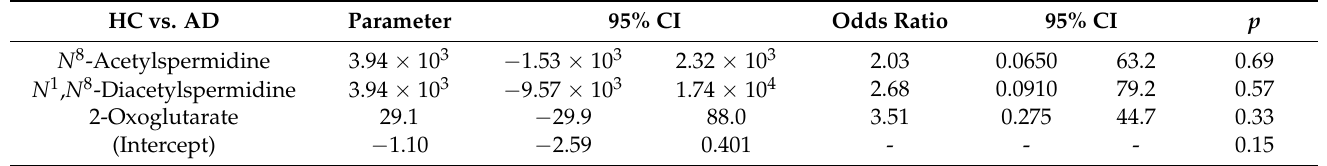
Figure 4. Pathway analysis using integrated datasets (data 1 and data 2). ( A ) HC vs. AD, ( B ) AD vs. CRC, and ( C ) HC vs. AD + CRC. The x and y -axes indicate pathways that impact and –log 10 P, respectively. The pathways showing ( A ) p < 0.05, ( B ) p < 0.01, and ( C ) p < 0.001 are labeled with pathway names. Red and yellow indicated higher and lower P -values. Larger dots indicate a higher impact score. Table 2. MLR model to discriminate AD from